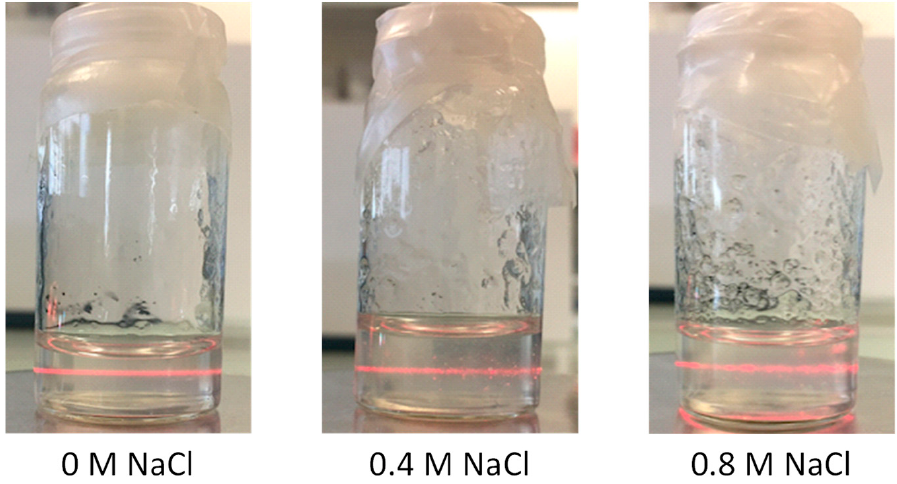
Figure 4. Laser light scattering observation ( λ = 650 nm) for a qualitative evaluation of turbidity of 0.45% w/w CNF suspensions with different NaCl concentrations. The suspensions at pH = 5.1 were not significantly affected by the presence of NaCl salt in the range 0 to 0.8 M.